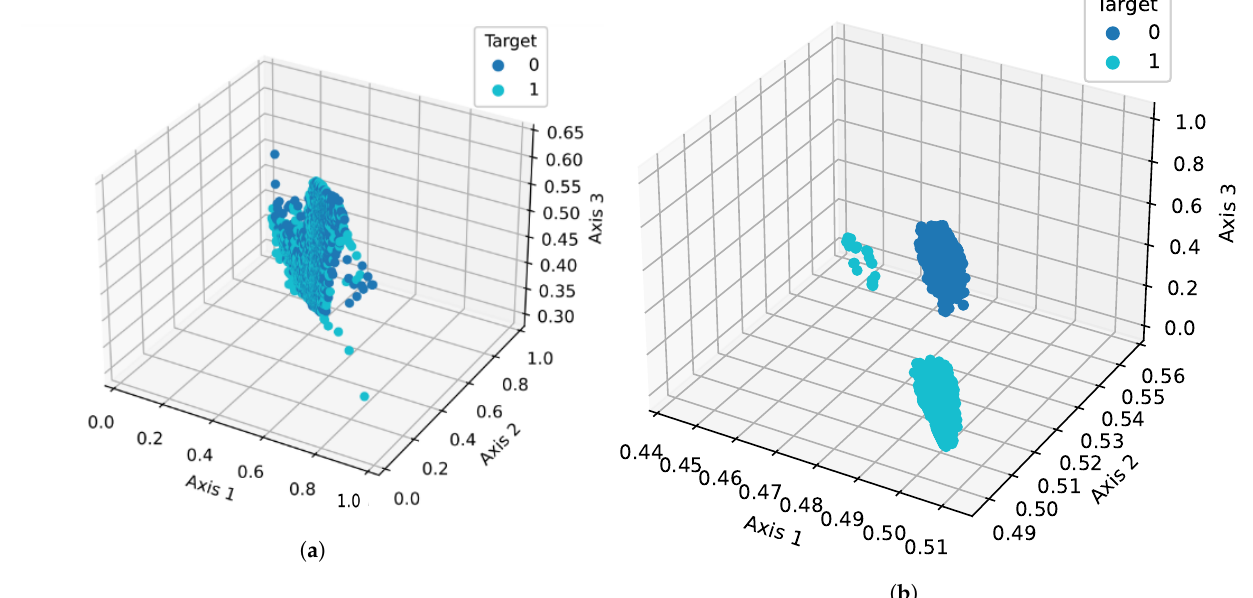
Figure 6. Feature space, ( a ) Class distribution using the original features, and ( b ) Class distribution using the proposed PBF.